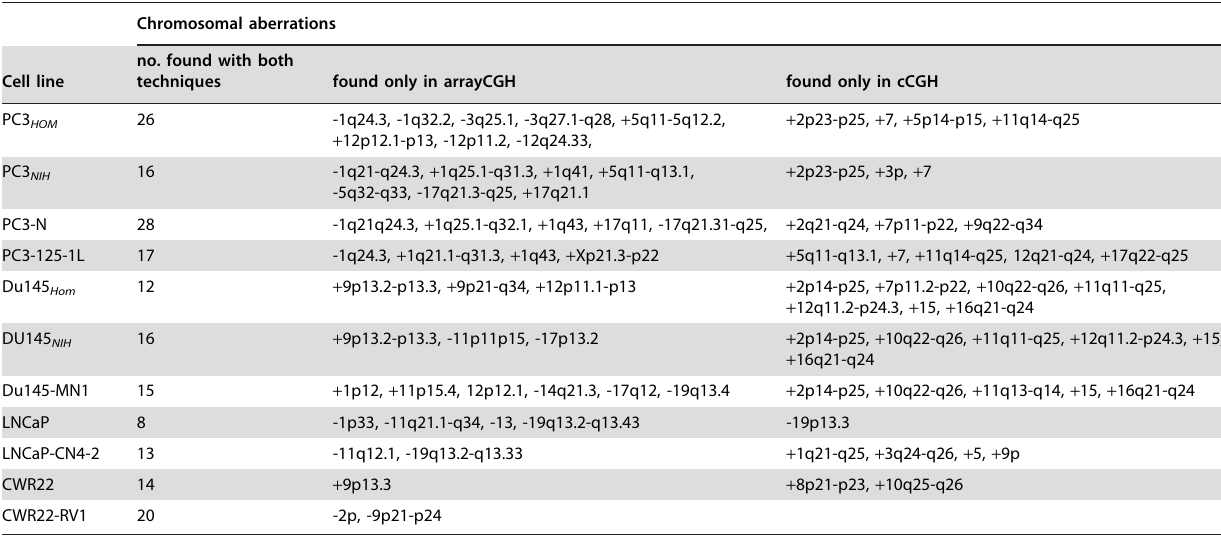
Table 1 . Overview of detected chromosomal aberrations by cCGH and aCGH .. ... .... ... ... .... ... ... .... ... ... .... ... ... .... ... ... .... ... ... .... ... ... .... ... ... .... ... ... .... ... ... .... ... ... .... ... ... .... ... ... .... ... ...